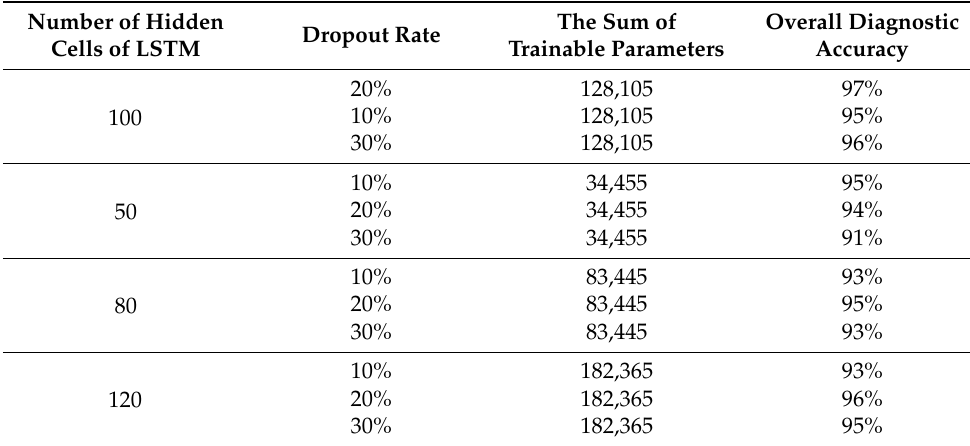
Table 9. Comparison of different parameter Settings in LSTM